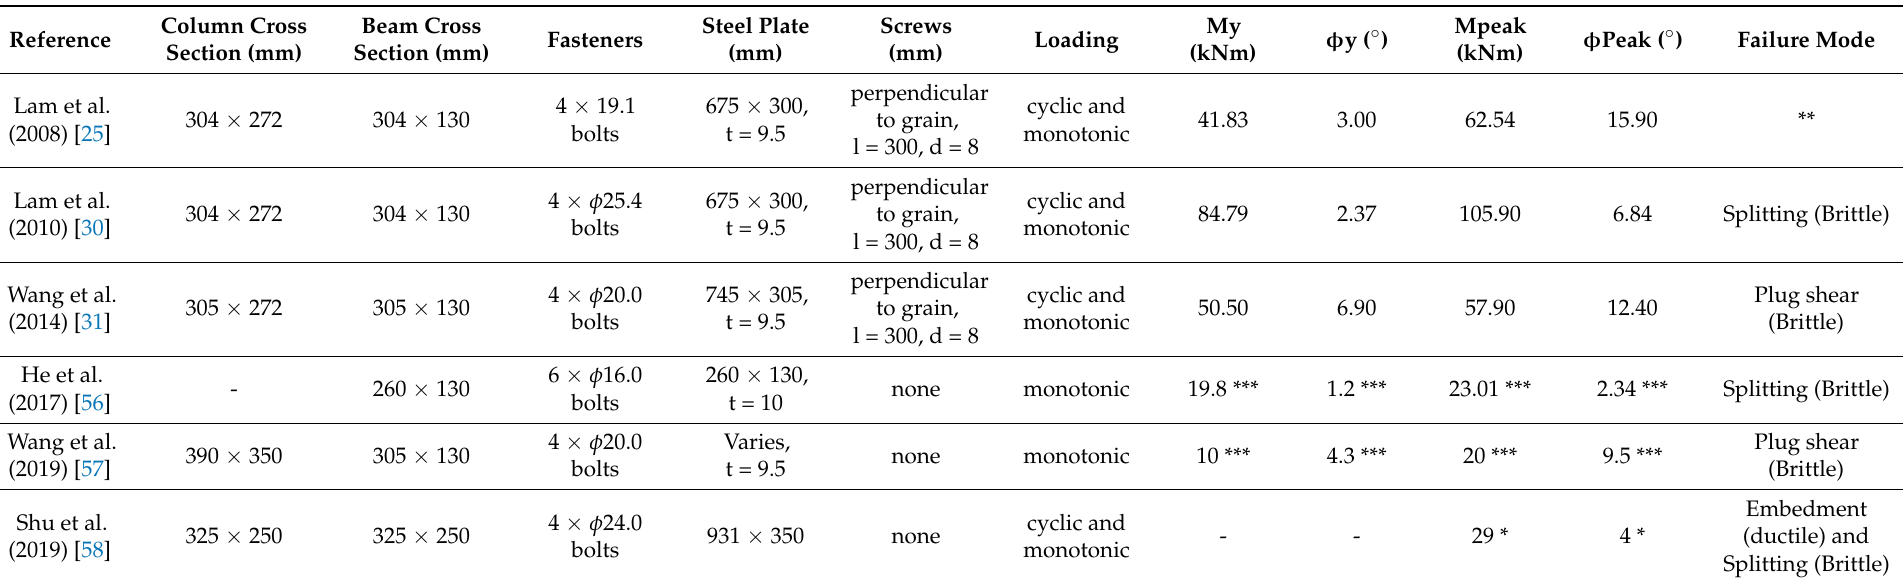
Table 5. Comparison of the collected experimental results for bolted connections with slotted-in steel plates (adapted from Ref.